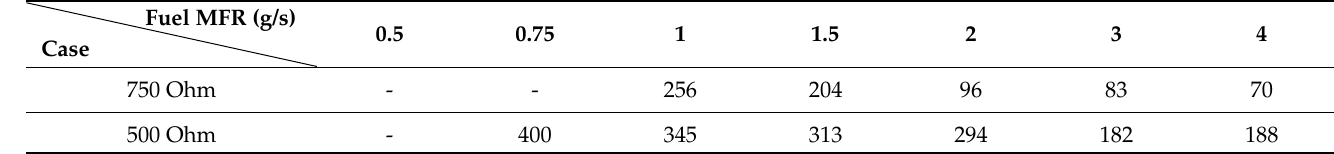
Table 2. Frequency (Hz) of flame front oscillations.